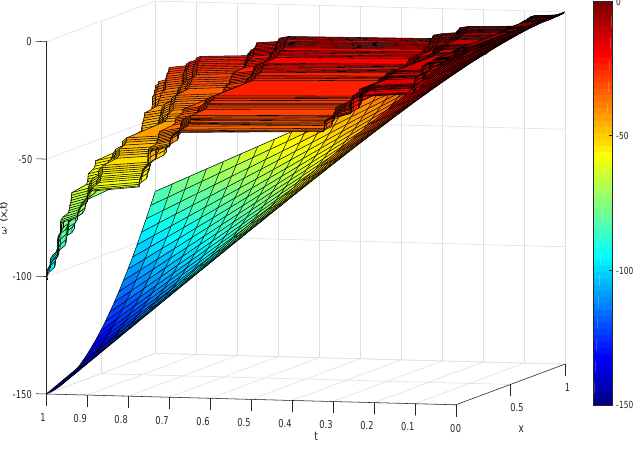
Figure 4. Comparison of integer order ε = 1 and fractional dimension ε = ln 2/ ln